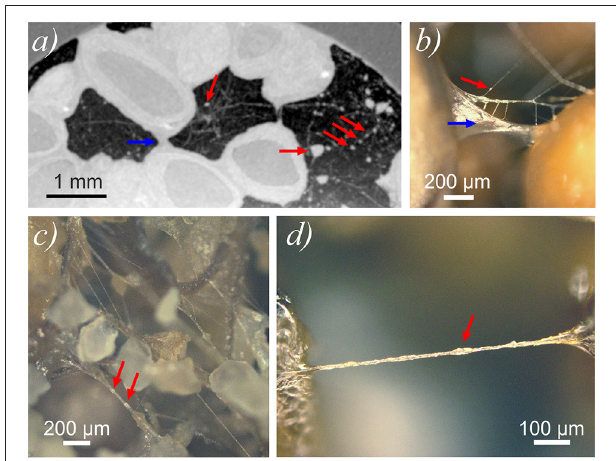
FIGURE 6 | (a) Cutout of a horizontal slice of CT scan (chia pure) showing the filamentous network within air-filled voids including agglutinations (red arrows) of hydrated material. Larger hydraulic bridge indicated by blue arrow. Filamentous network was visualized by projecting the maximum gray value over 208 µ m along the z-axis. Hydraulic bridge between chia seeds indicated by blue arrow. Pixel size in x- and y-direction is 20.8 µ m. (b–d) Light microscope images of dehydrated chia mucilage in Nafion (b) and in sand (c,d)